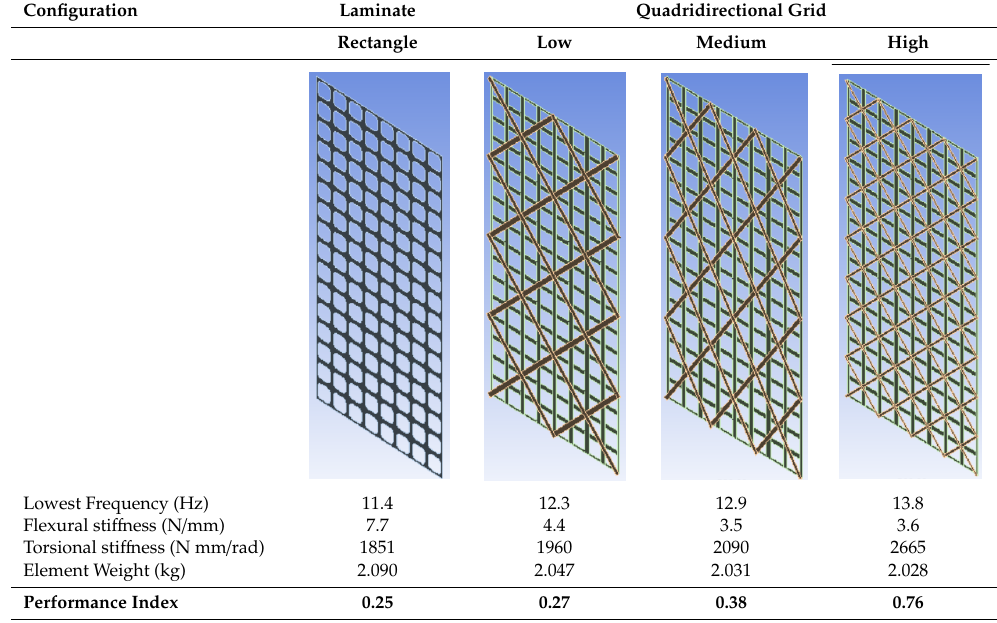
Table 7. E ff ect of changes in grid shape (at the level of mock-up). Table 8. Effect of changes in grid topology (at the level of mock-up).